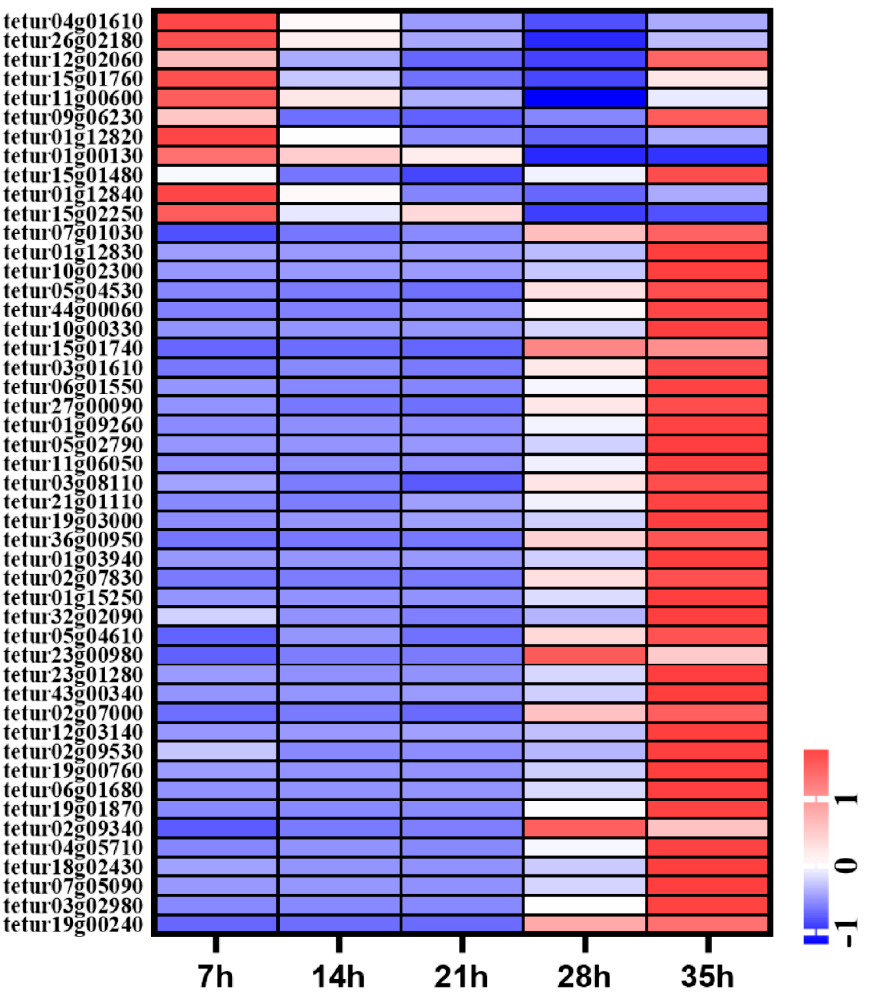
Figure 7. Expression profiles of CP genes in different time points of deutonymph in T. urticae . The color scales represent the values were normalized by Z-score ((value-mean value)/standard error) for each development time point.